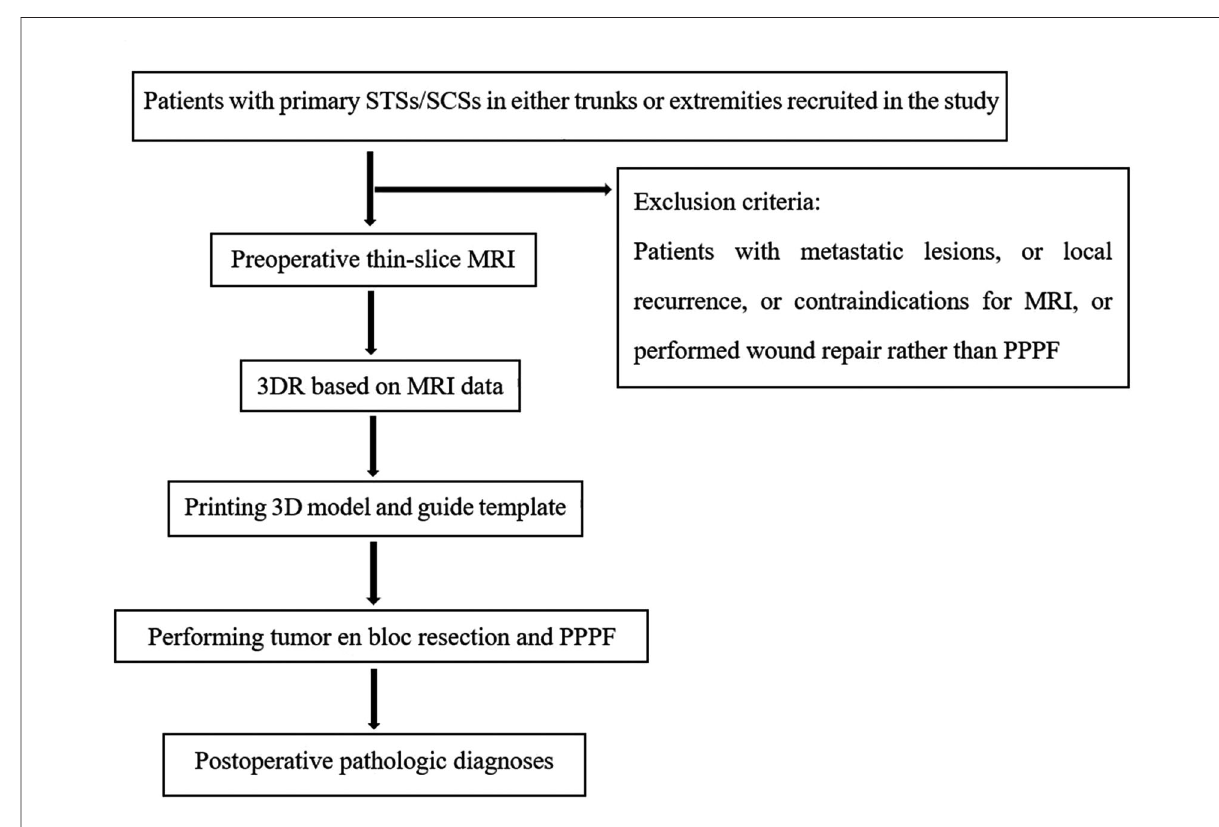
FIGURE 1 Work fl ow of our present